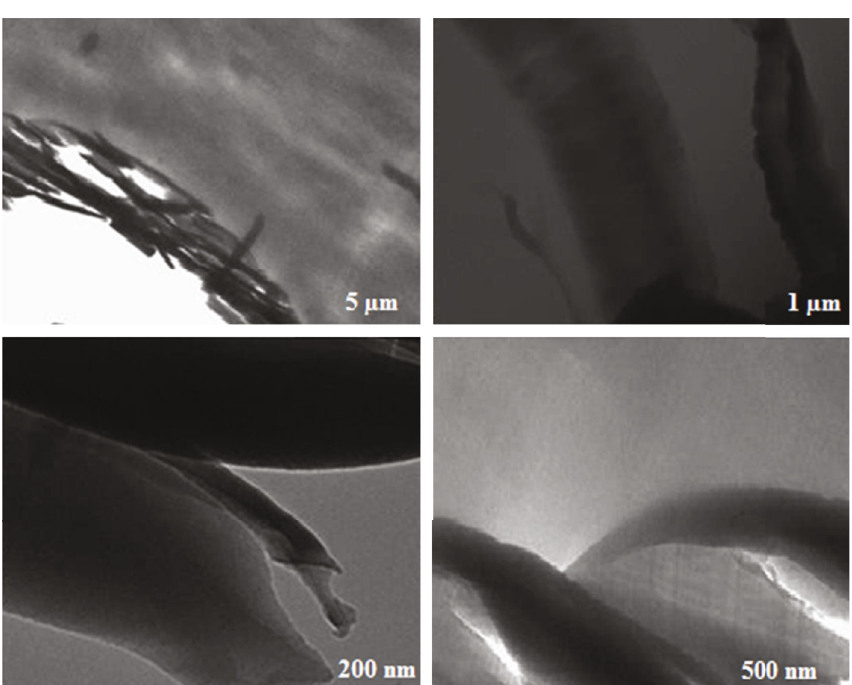
Figure 6: Transmission electron microscopic images of graphene oxide-blended glass- fi lled nylon at various magni fi